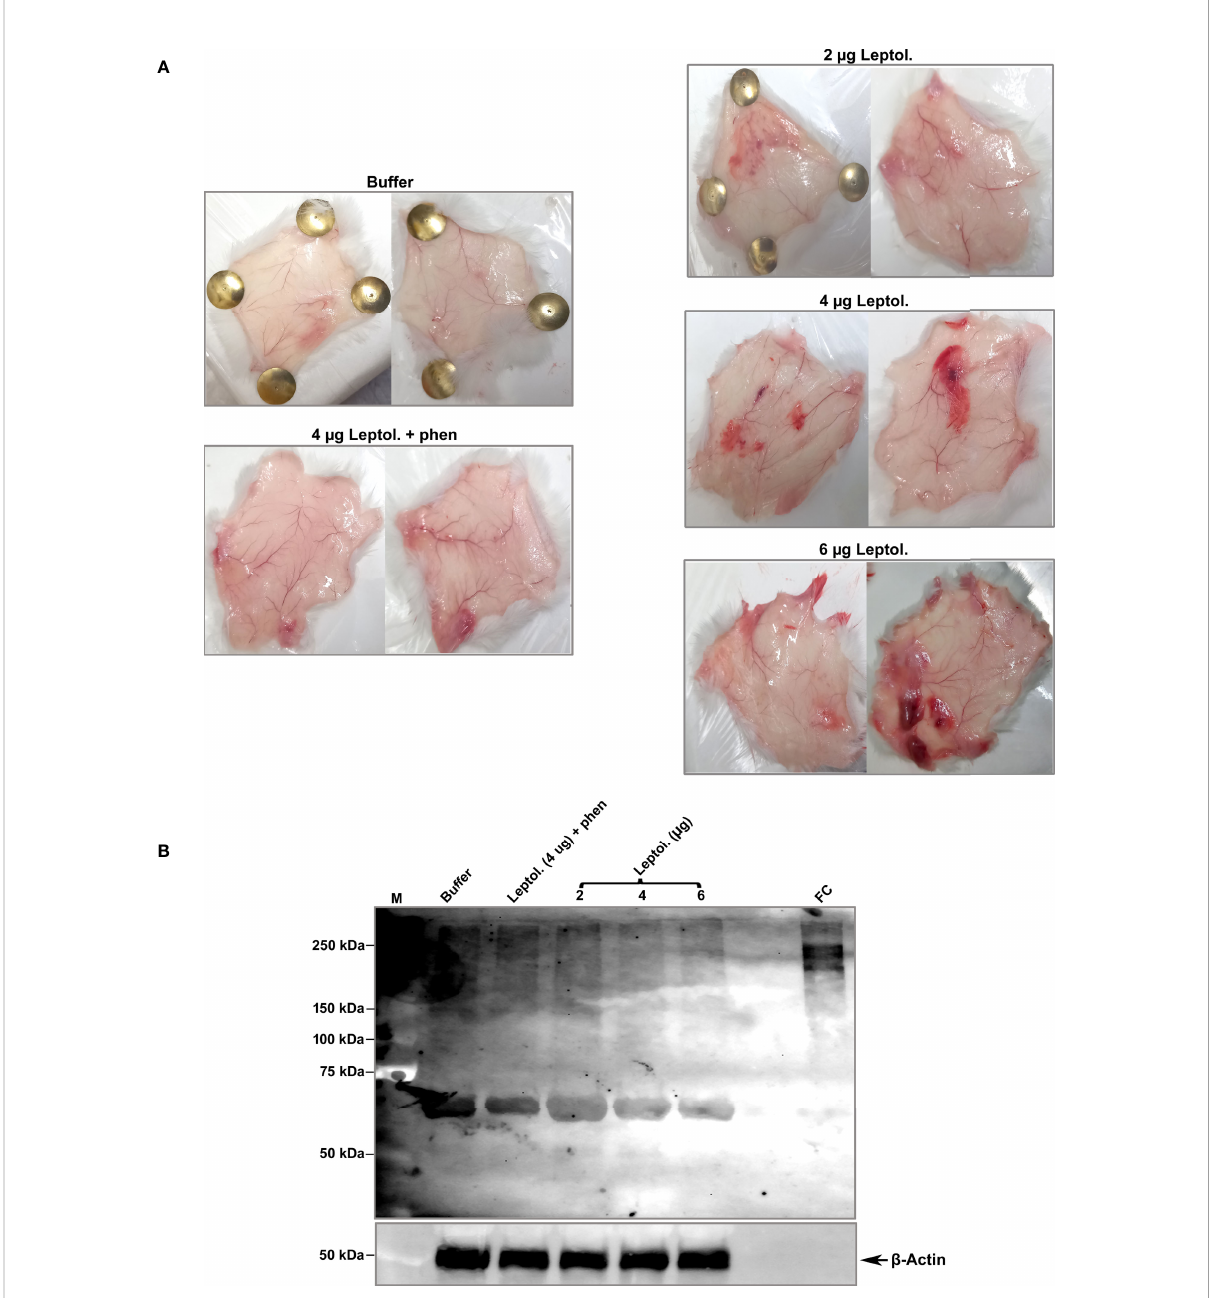
FIGURE 9 Degradation of fi bronectin isolated from mouse skin injected with L. interrogans leptolysin. (A) Control skins (animals injected with buffer or with 4 µg of leptolysin + 1,10 phenanthroline) and skins injected with 2 - 4 µg leptolysin are shown. (B) Protein samples (4 µg) isolated from mouse skins were analyzed by Western blot with anti- fi bronectin or anti- b actin as described in Materials and